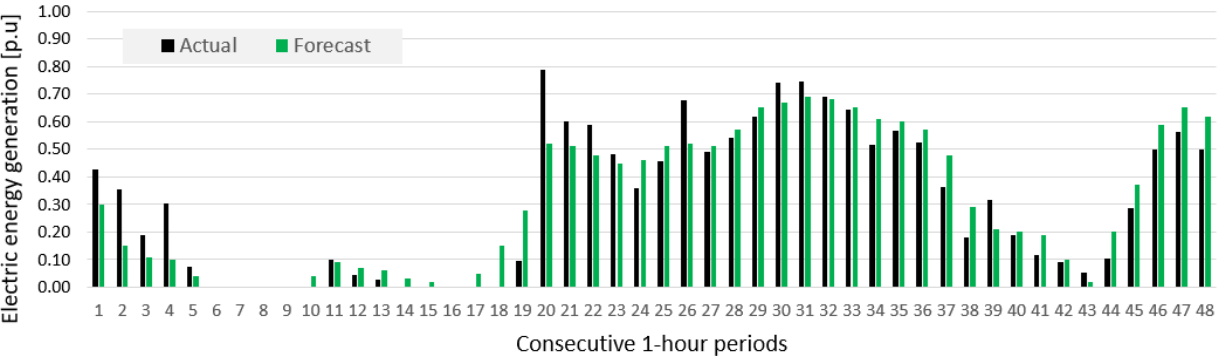
Figure 23. Two forecasts of electric energy generation for Wind Farm B made by INT_OUT_EXT [GBT, RF, PHYS(v1&v2) → KNNR, MLP, LSTM] method with additional expert correction for two consecutive days of the spring month (April).